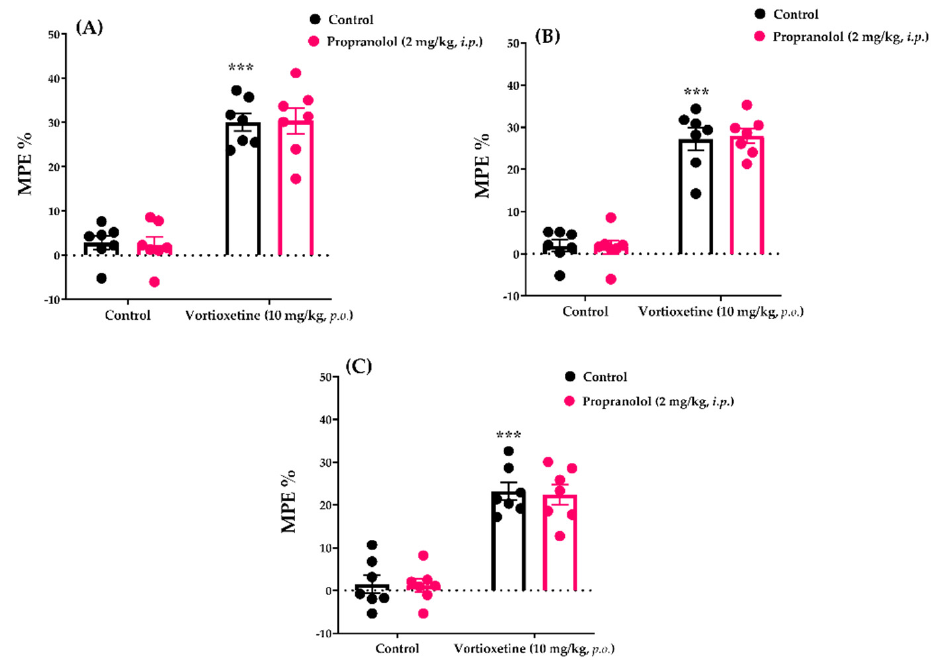
Figure 9. Involvement of β -adrenergic receptors in the analgesic effects of vortioxetine in the tail- clip ( A ), tail-immersion ( B ) and hot-plate ( C ) tests. Significant difference against vehicle treated control groups *** p < 0.001. Two-way ANOVA, post-hoc Bonferroni test, n = 7.